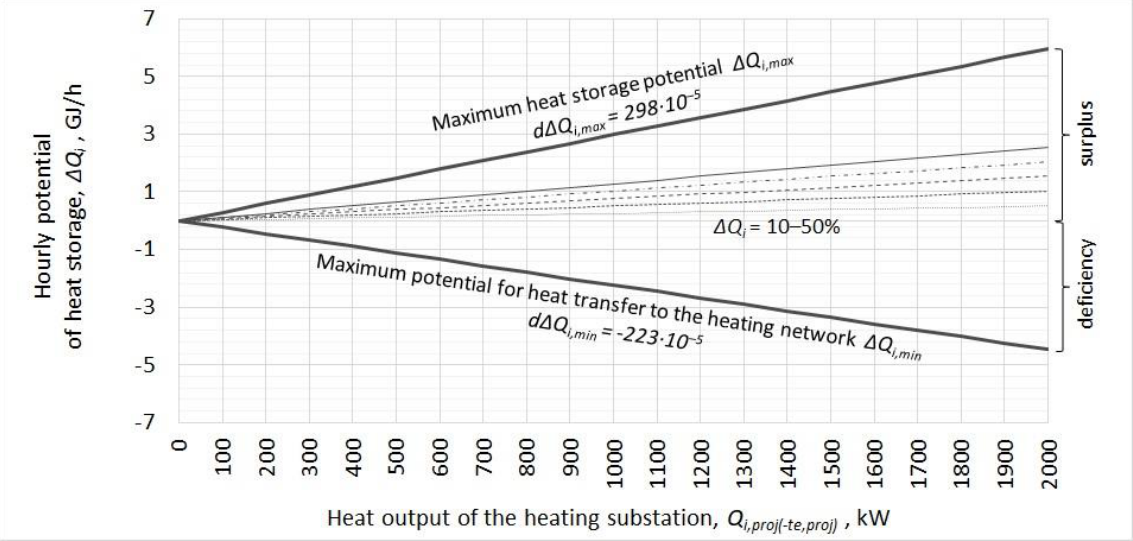
Figure 4 . Nomogram for the selection of theoretical, average hourly potential of heat storage .